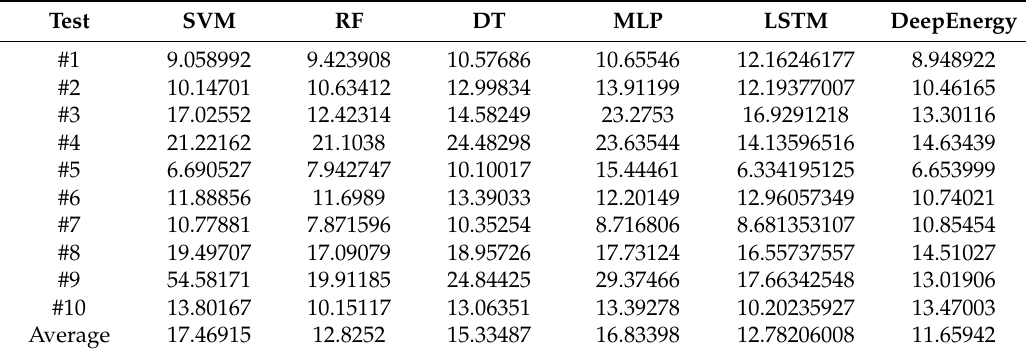
Table 2. The experimental results in terms of Cumulative Variation of Root Mean Square Error (CV-RMSE) given in